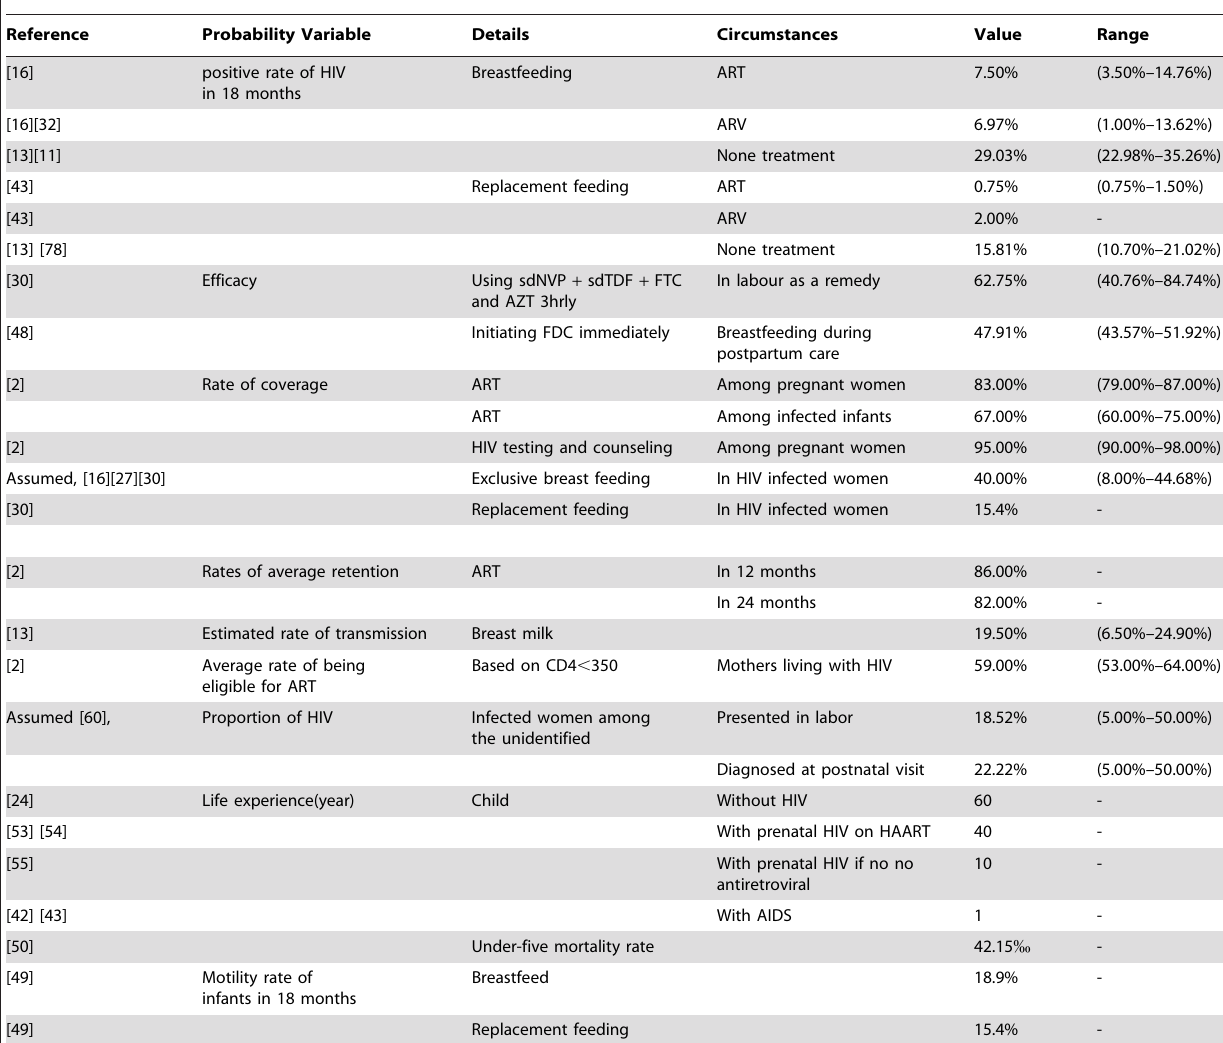
Table 1. References and input probabilities for the decision analytic model.